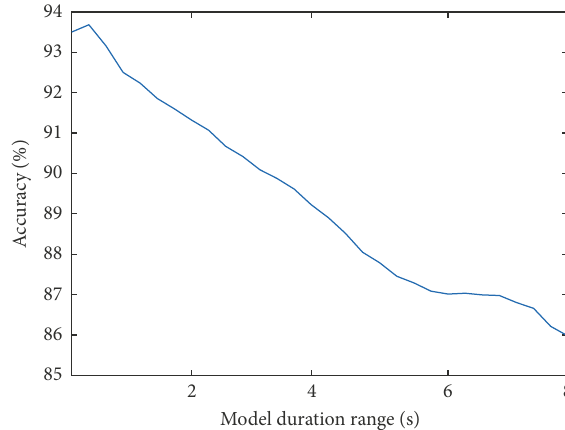
Figure 12: Dependence of the distribution range to the accuracy of the HSHMM classifier. The graph is showing that the accuracy decreases almost linearly with the increase of the movement dura- tion